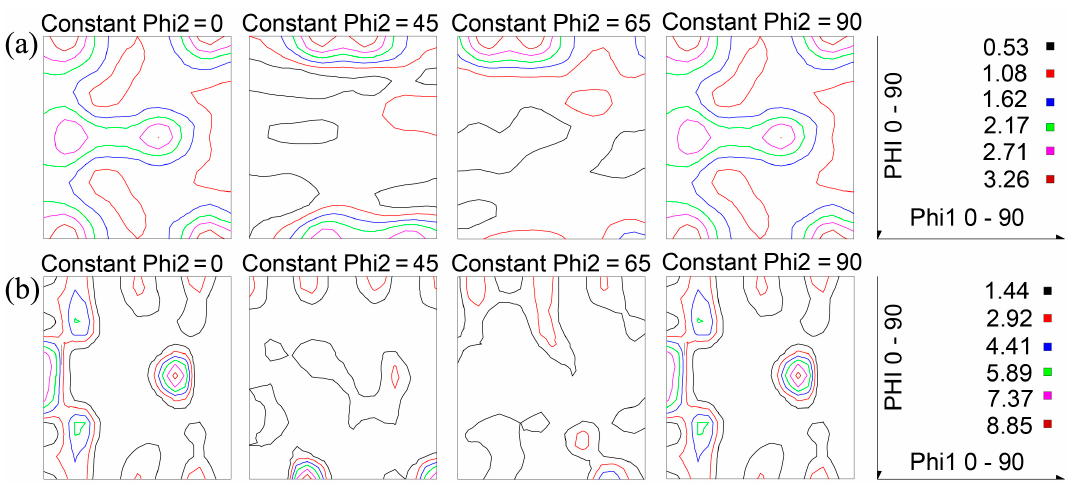
Figure 3. Texture measurement results showing orientation distribution functions (ODFs) section for sample A ( a ) and sample B ( b ).